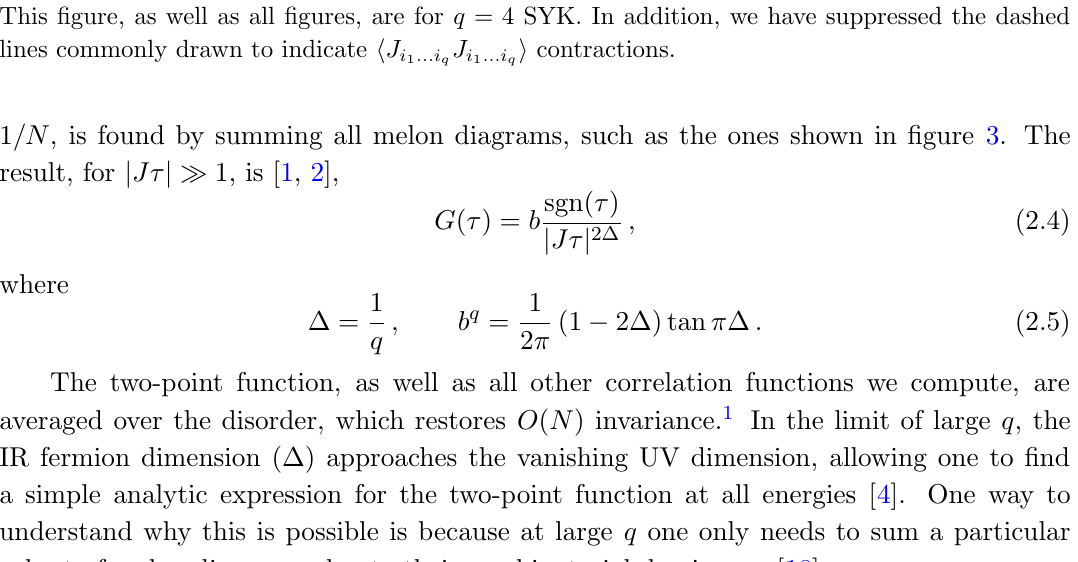
Figure 3. The fermion two-point function, to leading order in 1 =N , is a sum of melon diagrams. This (cid:12)gure, as well as all (cid:12)gures, are for q = 4 SYK. In addition, we have suppressed the